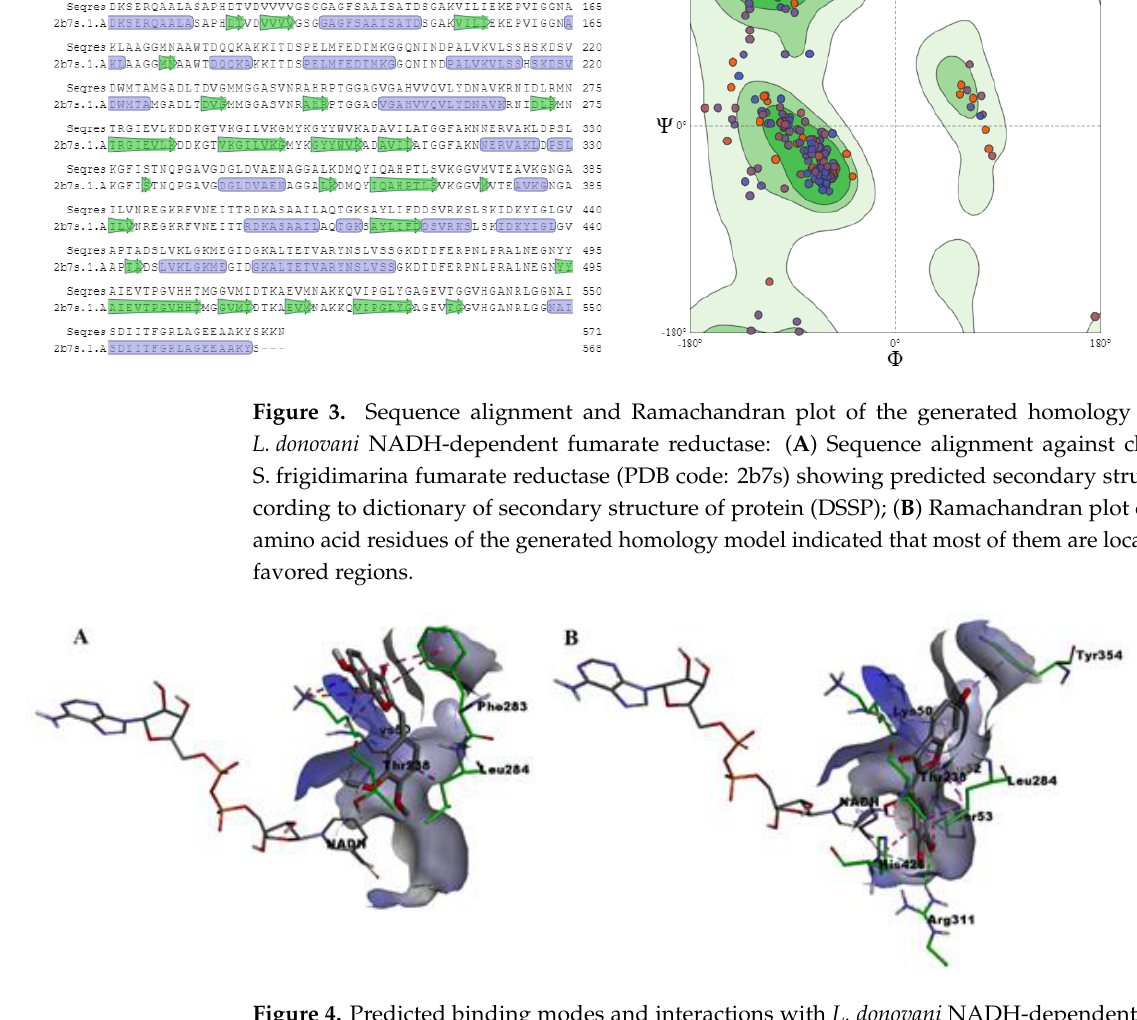
Figure 4 . Predicted binding modes and interactions with L. donovani NADH-dependent fumarate reductase: ( A ) Predicted binding mode and interactions for sulfuretin analogs 1i ; ( B ) Predicted binding mode and interactions for sulfuretin analogs 1q .